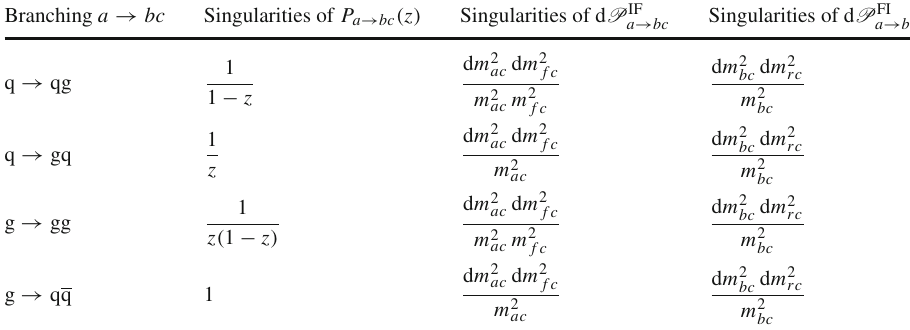
Table 1 Singularity structure of the probability of emission for IF and FI. For IF, the parton b in the branching a → b + c is the one which was incoming before the backward evolution. The mapping between IF and FI labels is the following: a ↔ r , f ↔ b and c ↔ c